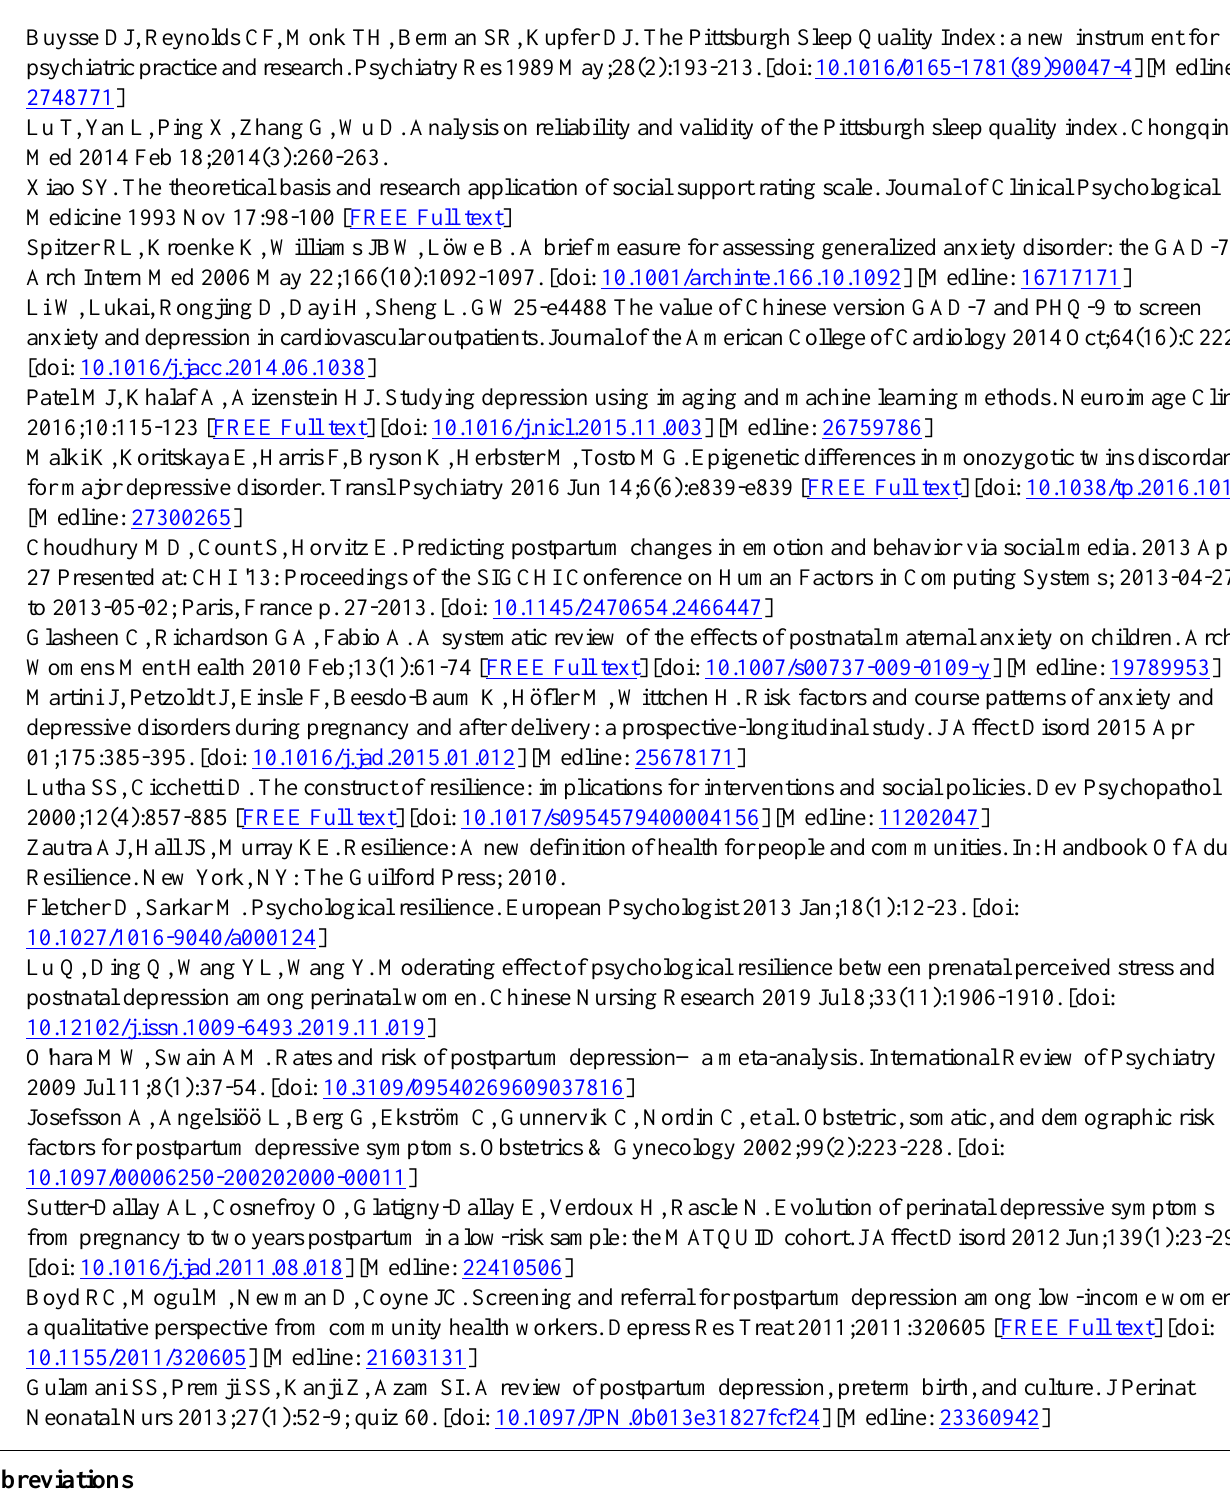
EPDS: Edinburgh Postnatal Depression Scale F-RF: model built using the random forest algorithm and Random forest-based filter feature selection method F-SVM: model built using the support vector machine algorithm and Random forest-based filter feature selection method FFS-RF: random forest-based filter feature selection GAD-7: Generalized Anxiety